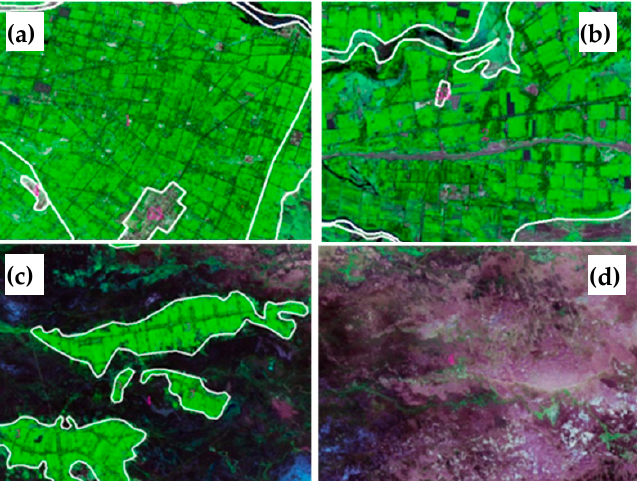
Figure 2. The soil salinization interpretation reference database for different salinized soil grades. Sub-figure ( a – d ) represent slightly salinized soil, moderately salinized soil, severely salinized soil, and extremely severely salinized soil, respectively.